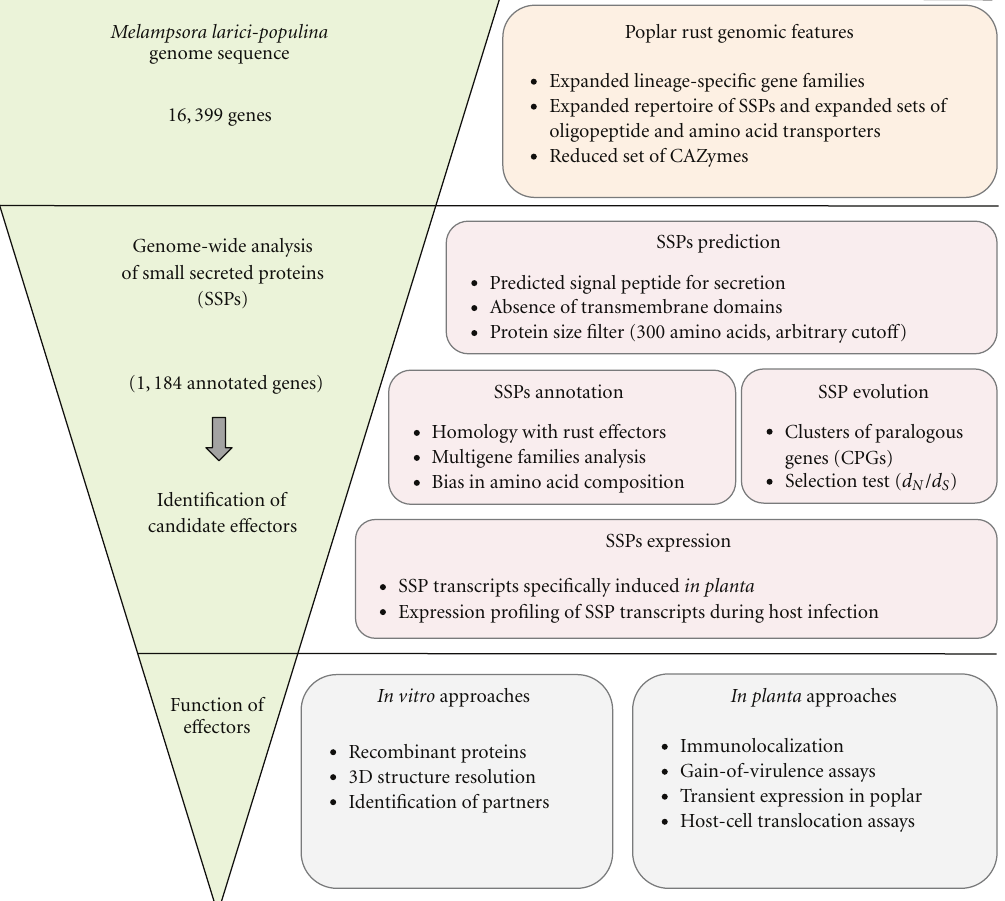
Figure 2: Roadmap for e ff ectors identification in Melampsora larici-populina